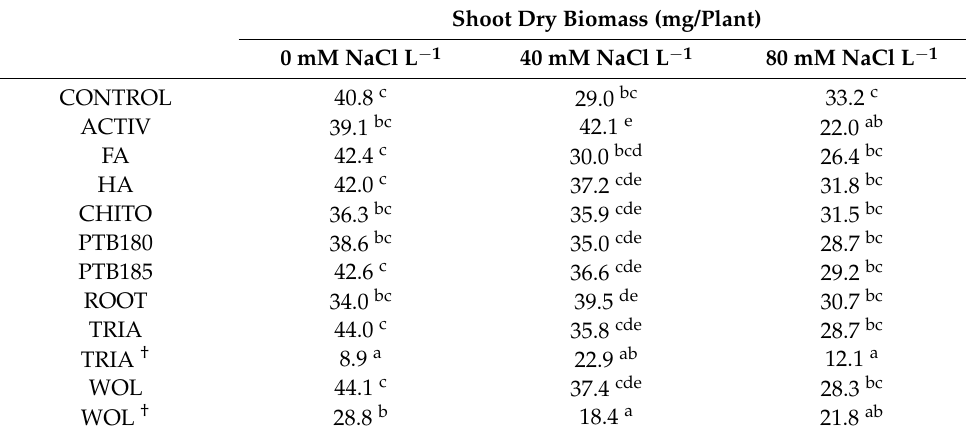
Table 6. Effect of biostimulants and salinity levels on the shoot dry biomass of baby leaf lettuce plants under organic